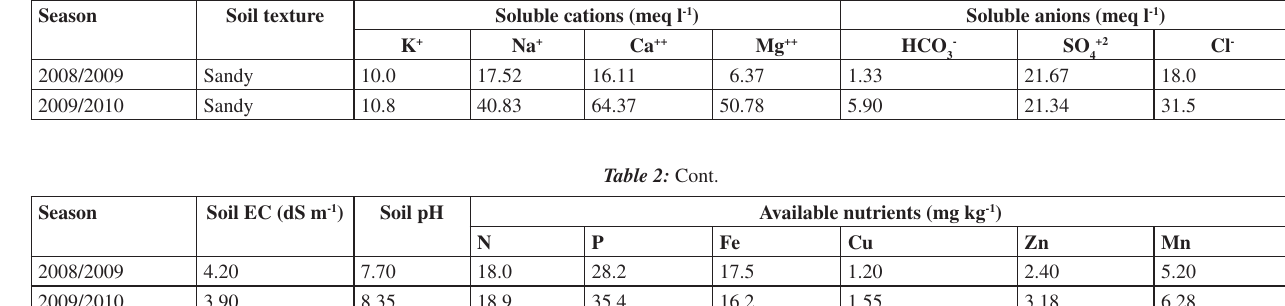
Table 2: Physical and chemical analysis of the experimental soil in 2008/2009 and 2009/2010 seasons